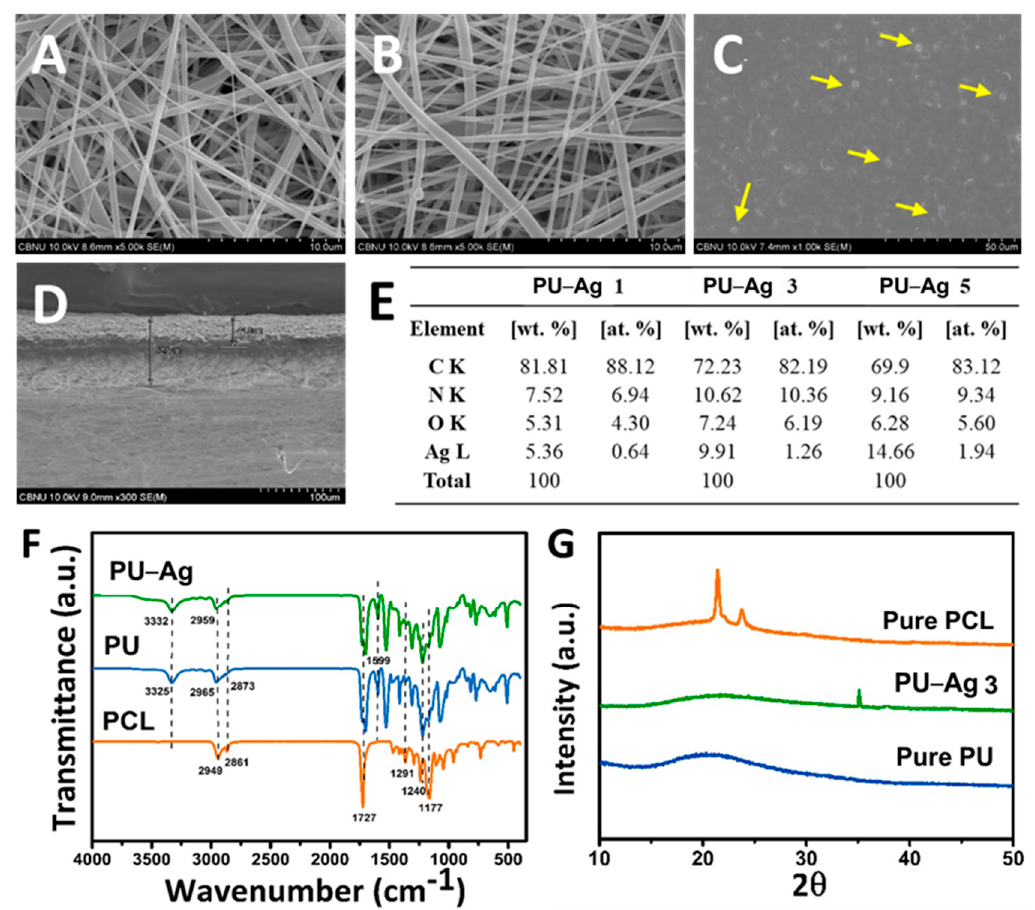
Figure 2. FE-SEM images of: ( A ) PCL nanofibers; ( B ) PU–PTX nanofibers; ( C ) PU–Ag film; and ( D ) cross-section of nanofibrous PU–PTX and PU-Ag film layer. ( E ) EDS analysis showing different concentration (1%, 3%, and 5%) of Ag in PU–Ag film. ( F ) FT-IR and ( G ) XRD results of PCL, PU, and PU–Ag 3. FT-IR spectra of pure PCL and PU and composite PU-Ag samples are represented in